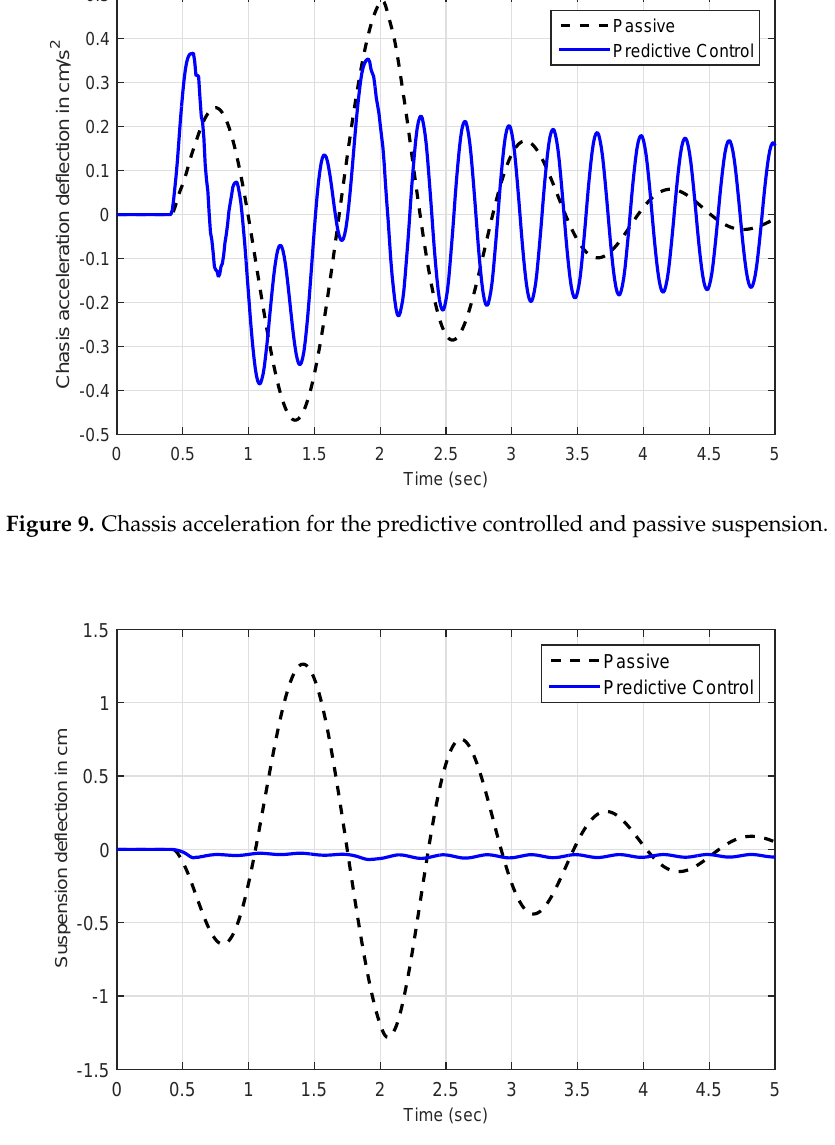
Figure 10. Suspension deflection for the predictive controlled and passive